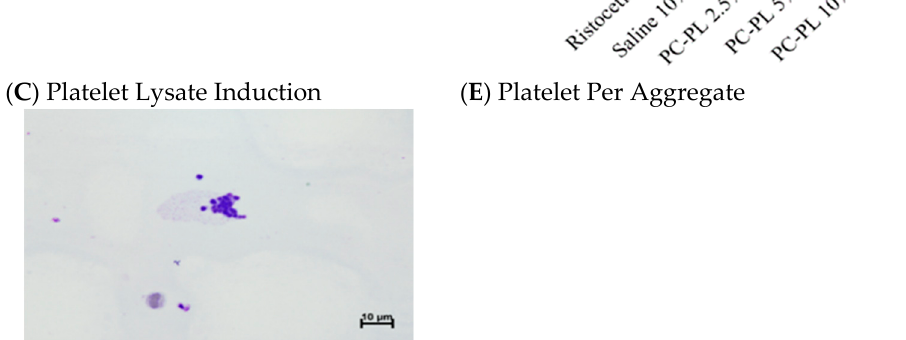
Figure 1. Effects of platelet lysate on platelet aggregation in direct mixing of platelet lysate with platelet-rich plasma. Percentage changes in platelet concentrations ( A ) and large cell ratio of platelet ( B ) affected by platelet lysate in different concentrations. Platelet lysate ( C ) and ristocetin ( D ) induced platelet aggregation in platelet-rich plasma. ( E ) Number of platelets per aggregate was induced by different concentrations of platelet lysate. In panels ( A , B , E ), ristocetin and 50% saline were used as positive and negative controls, respectively, and n = 10 in each experimental group. PC-PL, platelet concentrate–platelet lysate. PC-PL 2.5–10% indicates different platelet lysate fractions in the mixture. * p < 0.05 versus the saline group in the Student’s t -tests.